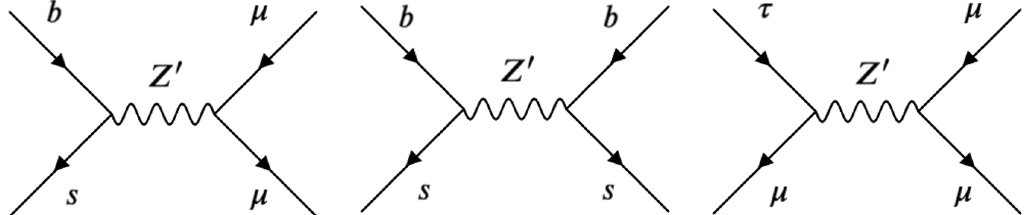
Figure 5 . These Z 0 exchange diagrams contribute to R τ → µµµ (right). The couplings are defined as g bs Z 0